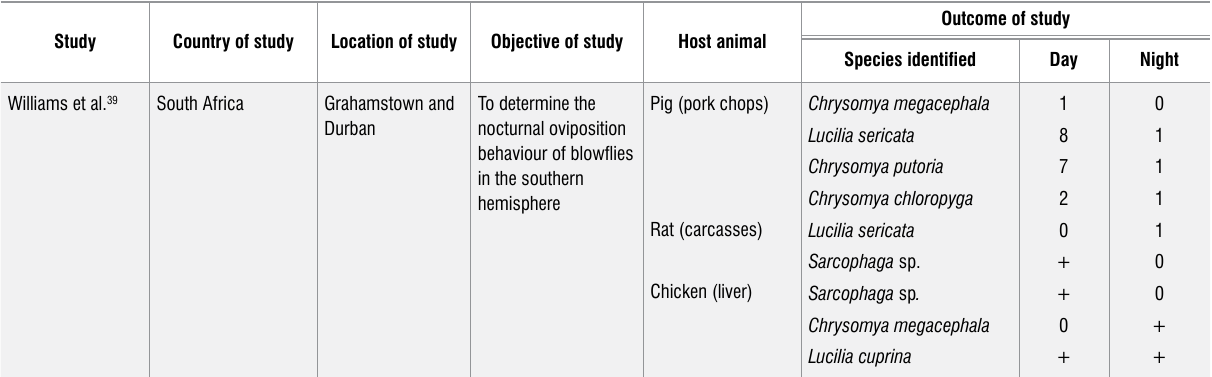
Study Country of study Williams et al. 39 South